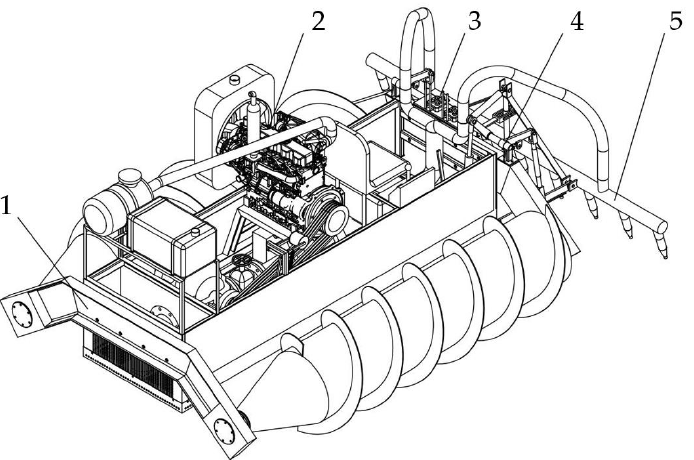
Figure 1. Structure of the wide-width root digger. 1. Twin-screw drive chassis 2. Power system 3. Hydraulic control system 4. Oscillating scouring adjustment structure 5. Hydraulic scouring system.